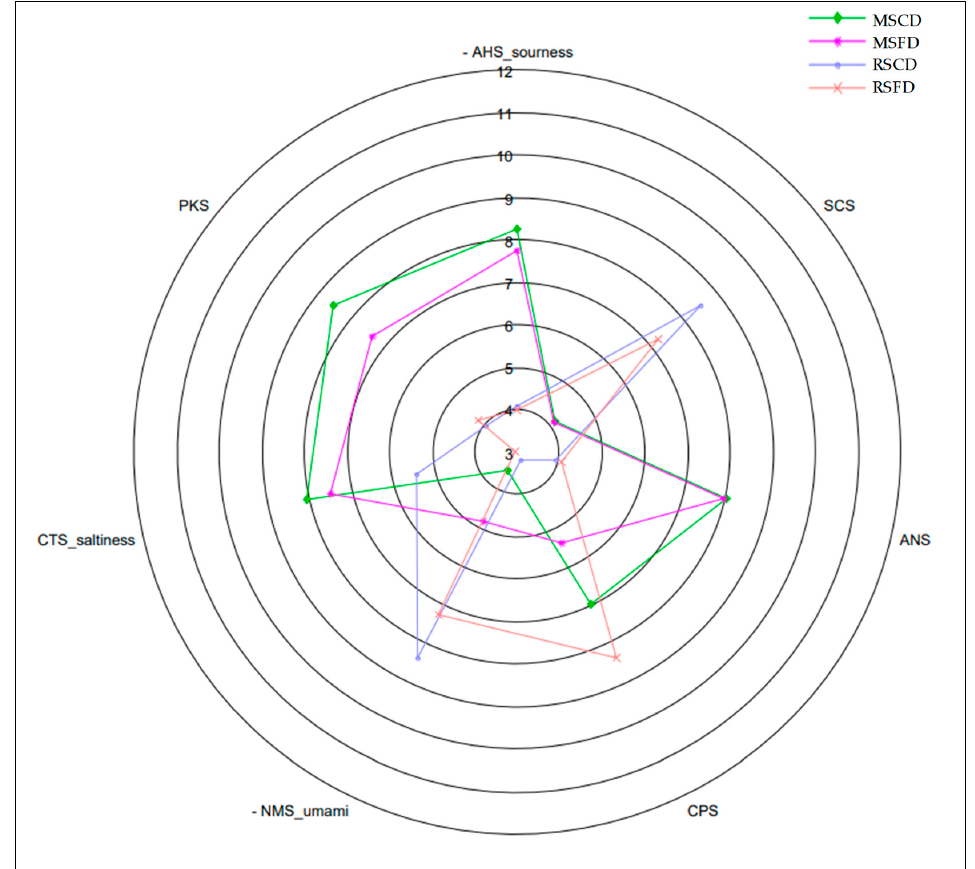
Figure 1. Radar fingerprint of E—tongue data for exotic fruit seed powders obtained by FD and CD drying methods; MSCD—convectionally dried mango seed powder; MSFD—freeze-dried mango seed powder; RSCD—convectionally dried rambutan seed powder; RSFD—freeze-dried rambutan seed powder.